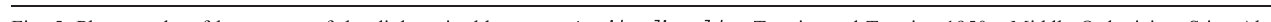
Fig. 5. Photographs of latex casts of the diploporite blastozoan Lepidocalix pulcher Termier and Termier, 1950a; Middle Ordovician, Stita, Algeria. A . MUA. 1023001; general aspect of the theca, in lateral view (A 1 ); enlargement of external surface (A 2 , turned 90° counter clock-wise), showing the central tubercles on the plates; enlargement of inner surface (A 3 ), showing the distribution of the diplopores and apparent imbrication of plates. B . MUA. 1024016; summit view of the theca (B 2 ), showing circlets of tessellate thecal plates; enlargement of the summit (B 3 , turned 90° clockwise), composed of four ambulacral rays recumbent on ornamented facetal plates; enlargement of the right thecal periphery (B 1 ), showing tessellate plates ornamented with tubercles and long spines. C . MUA. 1023002; general outline of the theca (C 1 ); enlargement of the top of C 1 (C 2 ), showing the organisation of the peristome (Pe) and the periproct (AP). D . MUA. 1024022, showing some abraded spines revealing the diplopores. Scale bars 5